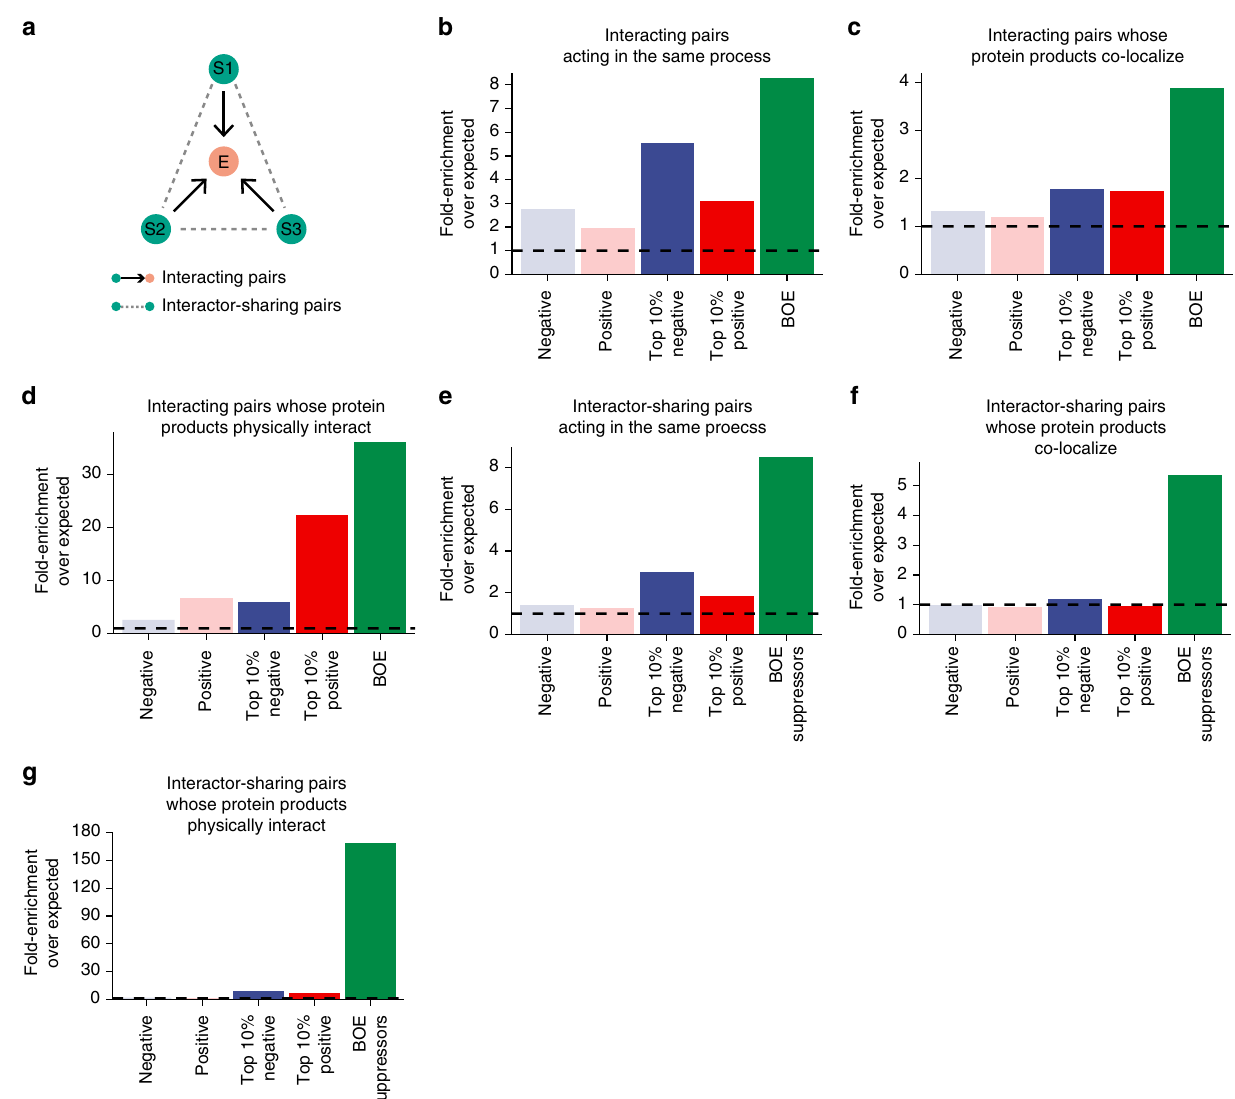
Fig. 6 BOE interactions are strongly correlated with functional relatedness. a Schematic depicting the two types of gene pairs for which the enrichment of functionally related genes within pairs were analyzed. b – d The numbers of observed interacting gene pairs in which b both genes are associated with the same biological process GO slim term, c the protein products of both genes are located in the same subcellular location, or d the protein products of the two genes physically interact, were compared with the expected numbers from all possible pairs generated by permutation. e – g The numbers of observed interactor-sharing gene pairs in which e both genes are associated with the same biological process GO slim term, f the protein products of both genes are located in the same subcellular location, or g the protein products of the two genes physically interact, were compared with the expected numbers from all possible same screen, we also isolated mutations affecting mmi1 , a known repressor of meiotic genes that contain DSR (determinant of selective removal) motifs, including rec8 43 , raising the possibility that erh1 and mmi1 function in the same pathway (Fig. 7a). A series of follow-up analyses found that Erh1 physically interacts with Mmi1 (Supplementary Figs. 7b, c), co-localizes with Mmi1 (Supplementary Figs. 7d, e), homo-oligomerizes (Supplementary Fig. 7 f), and mediates Mmi1 – Mmi1 interactions (Supplementary repression defect of erh1 Δ can be rescued by arti fi cial dimeriza-